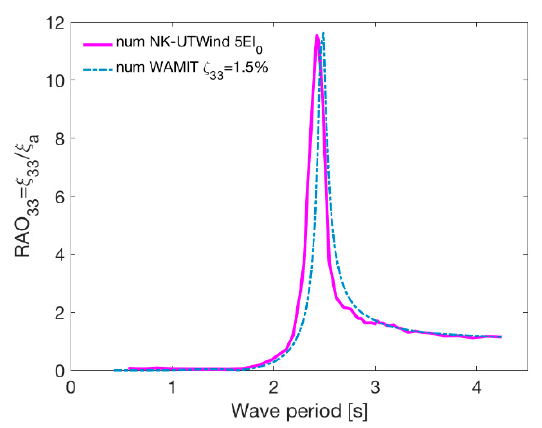
Figure 22. RAO heave motion result comparisons between the NK-UTWind and WAMIT numeri- cal calculations.